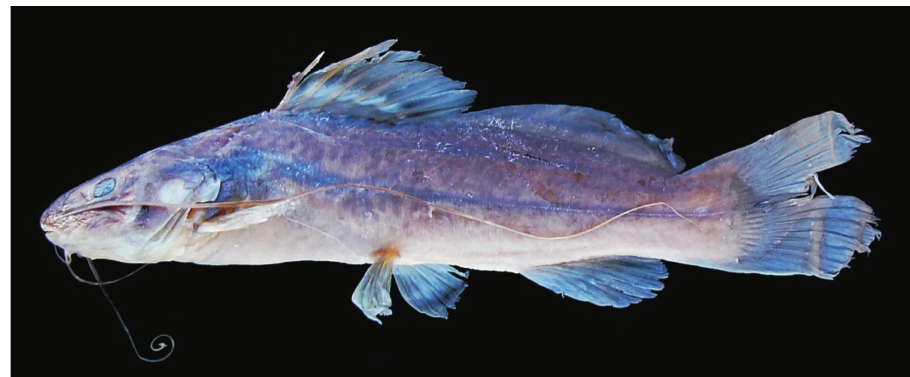
Fig. 8. Lateral view of Rhamdia quelen , neotype series, NRM 33452, 108.3 mm SL, Peru, Loreto, right bank quebradita tributary to rio Samiria between caño Pastos and